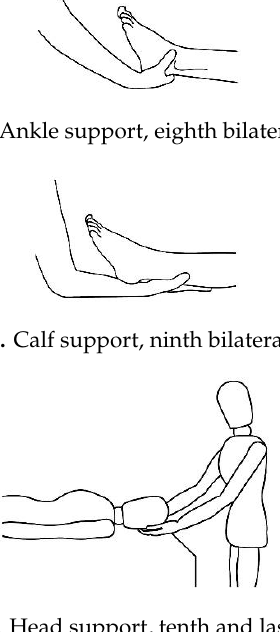
Figure 5. Head support, tenth and last touch.